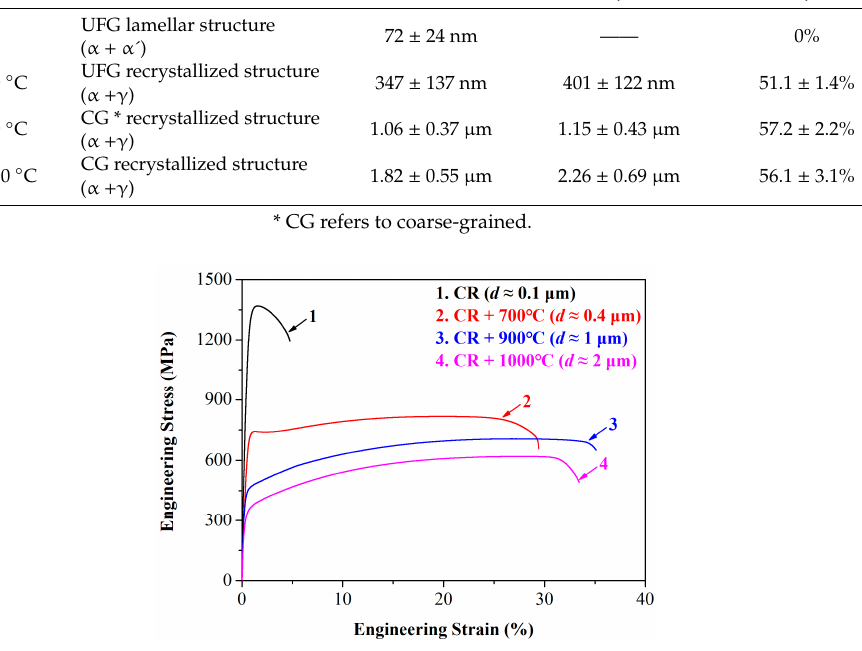
Figure 4. Engineering stress-strain curves of samples with different grain size scales.